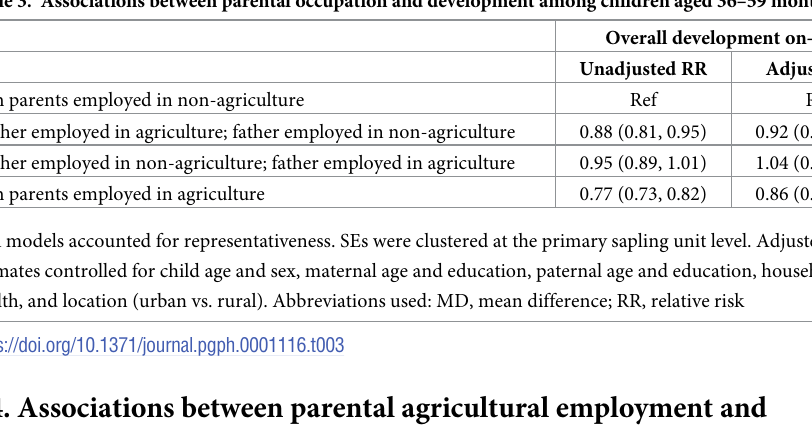
Table 3. Associations between parental occupation and development among children aged 36–59 months 1